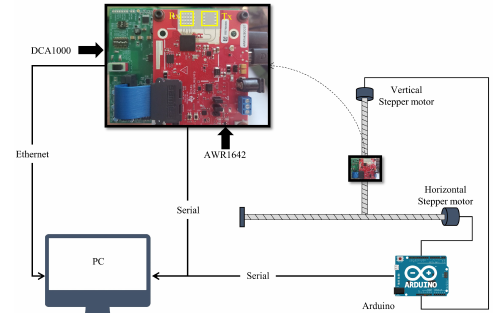
Figure 1. Schematic diagram of the developed MIMO GBSAR components